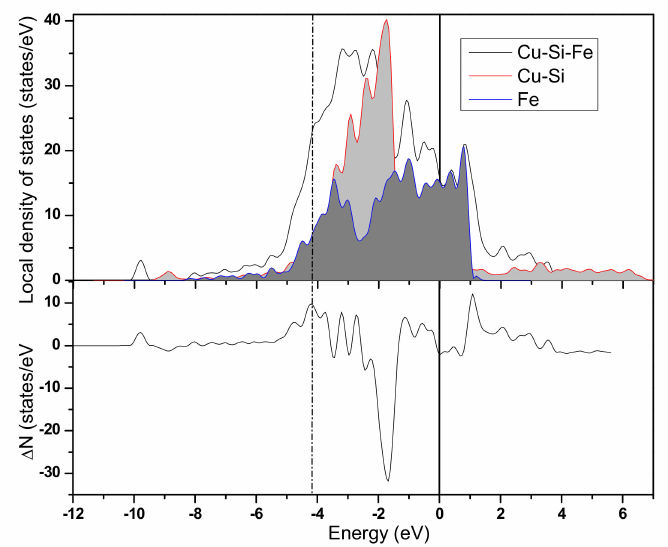
Figure 6. The LDOS of the binary Cu-Fe-Si system; the Fermi energy is set to 0 eV. ∆ N is the di ff erence between the LDOS of Cu-Si / γ –Fe system and that of Cu-Si(100) system and Fe(100) system. Compared with the LDOS analysis of the binary Cu / γ –Fe interface, in the ternary Cu-Si / γ –Fe interface, the calculated charge number of the bonding states increased from 10.79 to 12.10, indicating that more charge was transferred from Fe (Cu) to bonding states and that the bonding strength increased. More computational results about the charge number of the bonding states a ff ected by alloying elements were listed in Table 7. The calculation revealed that 5 elements Al, Ag, Mg, Cd